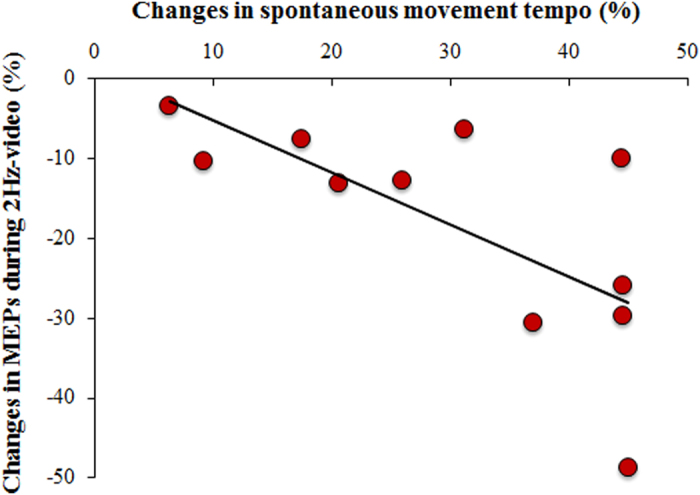
Correlation between changes in SMT and changes in MEPs amplitude induced by the 3 Hz-video training. Changes in SMT (X-axis) and in the left M1 excitability recorded during 2 Hz video observation (Y-axis) were evaluated as follows: SMT: (movement ratepost - movement ratepre)/movement ratepre*100; left M1 excitability = (MEPs amplitudepost-MEPs amplitudepre)/ MEPs amplitudepre*100) (Spearman’s rho = -0.72; p = 0.013).